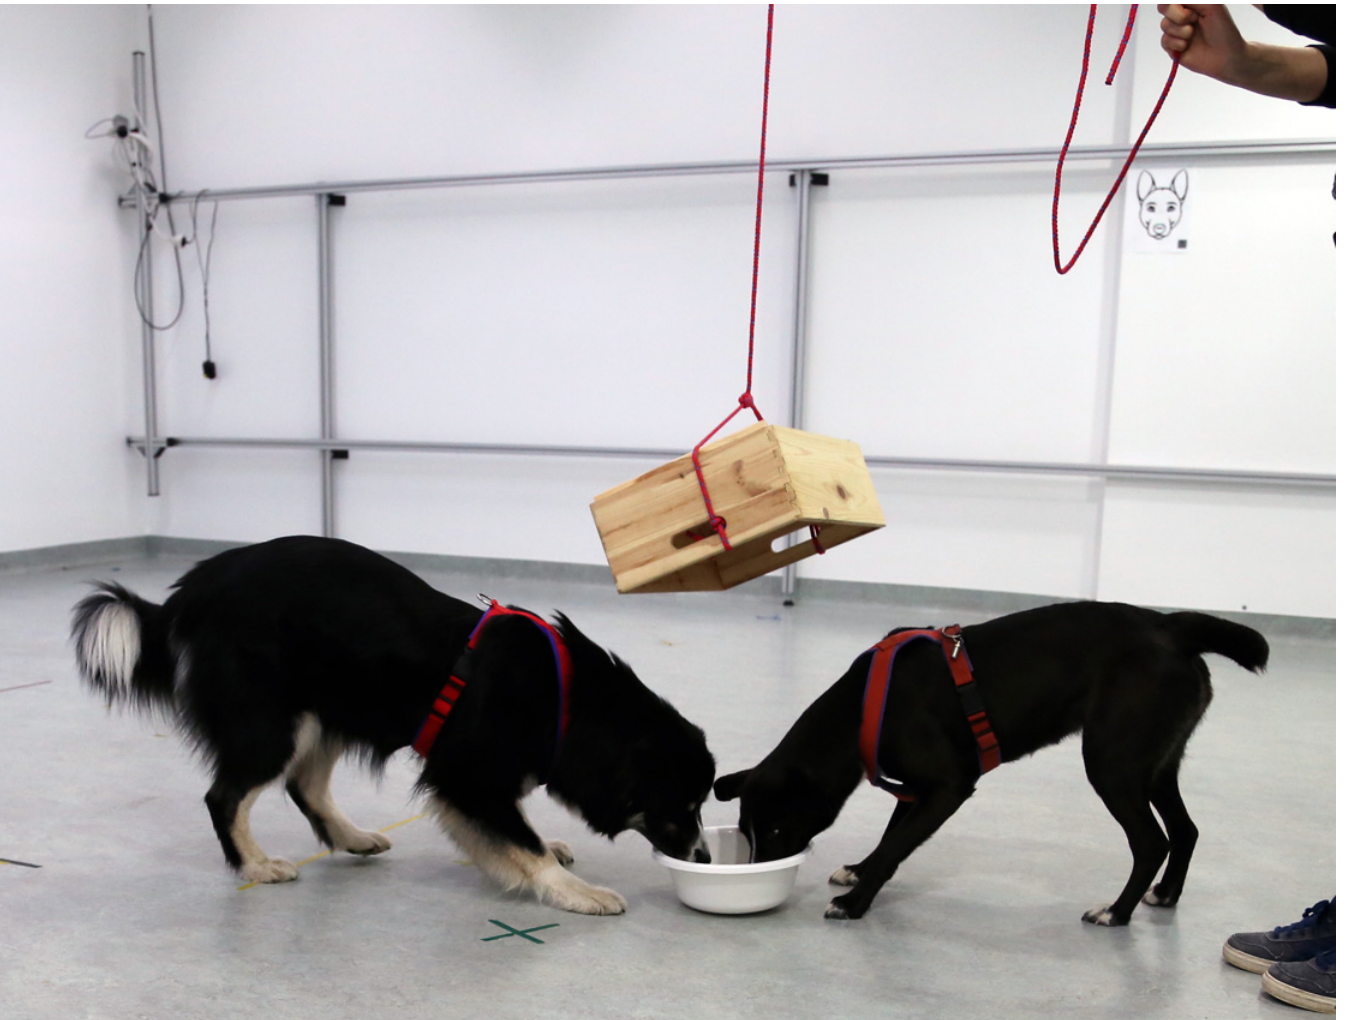
Fig 2. Setup for tolerance test. Dogs waiting for the box to be pulled up in order to access to the bowl containing pieces of sausages. The experimenter lifted the box when both dogs were within a 10cm radius of